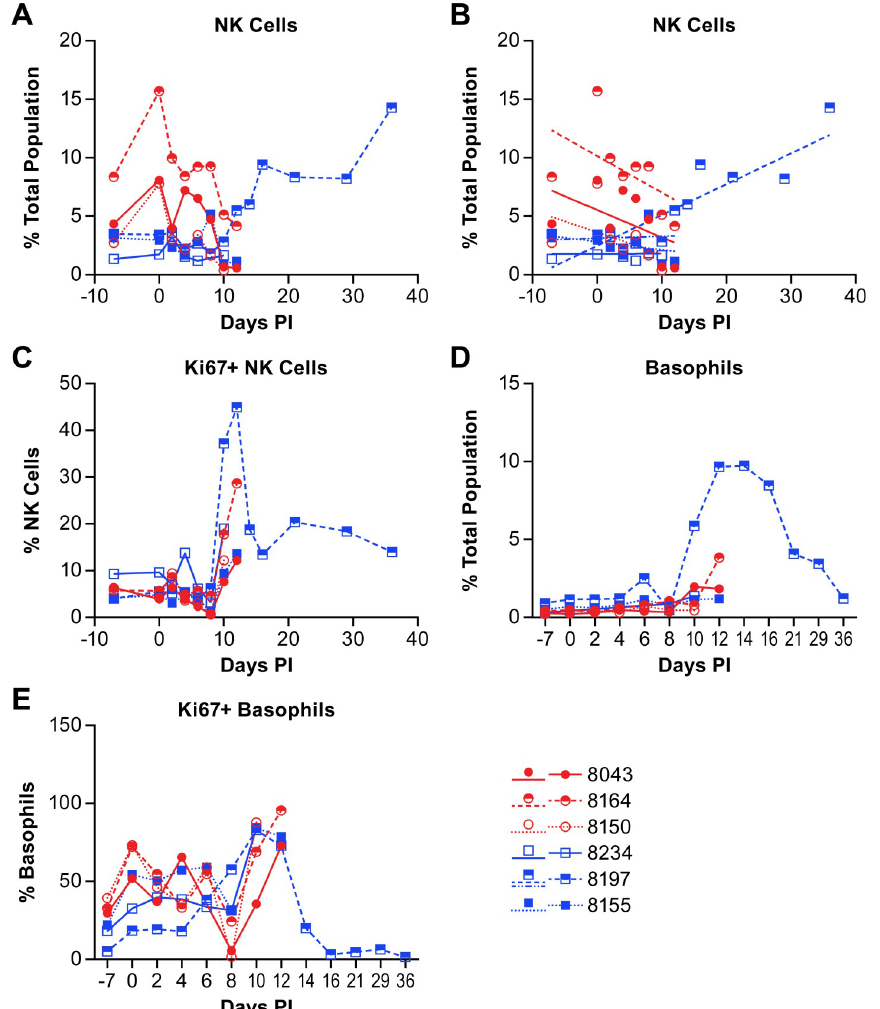
Fig 10. Changes in the populations of NK cells and basophils in animals infected with NiV. Data shows the changes in NK cell populations (A) within the total population of analyzed cells from animals infected with NiV over the course of disease and linear regression analysis (B) of these same populations. Linear regression analysis was performed on samples from all animals through day 12 (acute phase) with additional analysis of the surviving animal over the entire course of disease (blue dashed line). The level of Ki67+ (proliferating) NK cells (C), basophils (D) and Ki67+ basophils (E) were also evaluated. Red circles indicate the low dose group and blue squares indicate the high dose group. The cell surface markers for defining individual populations is provided in S3